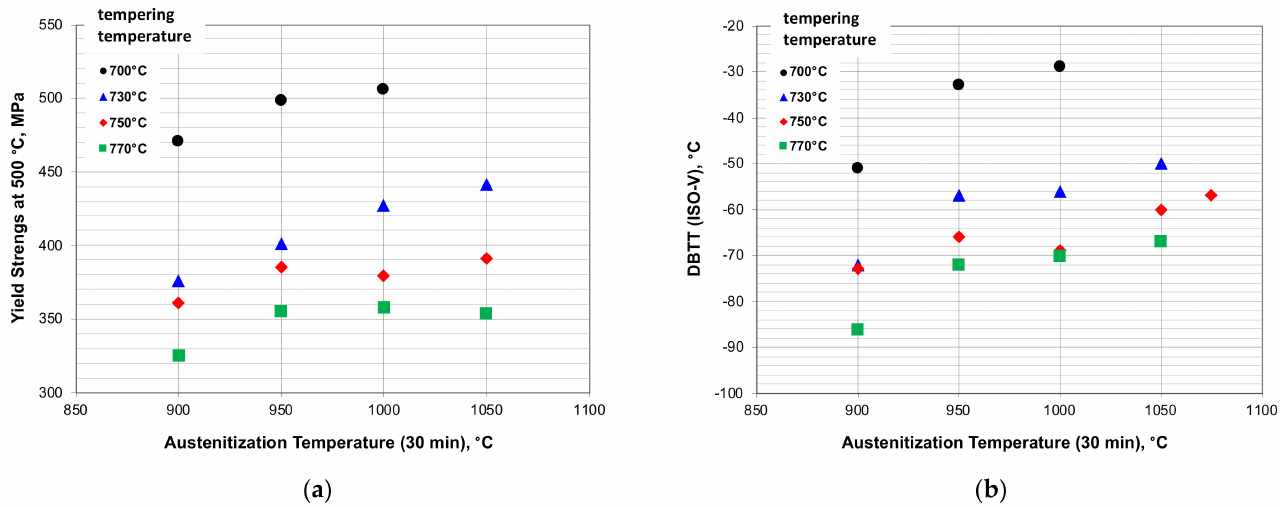
Figure 4. Effect of austenitization between 900 ◦ C and 1050 ◦ C for 30 min followed by air cooling and tempering between 700 ◦ C and 770 ◦ C for 2 h ( a ) on the 500 ◦ C-yield-strength of the EUROFER97 steel; ( b ) on DBTT of the EUROFER97 steel (measured with ISO-V Charpy specimens, for details see [28]). The yield strength and DBTT values are extracted and re-evaluated from the Charpy results given in